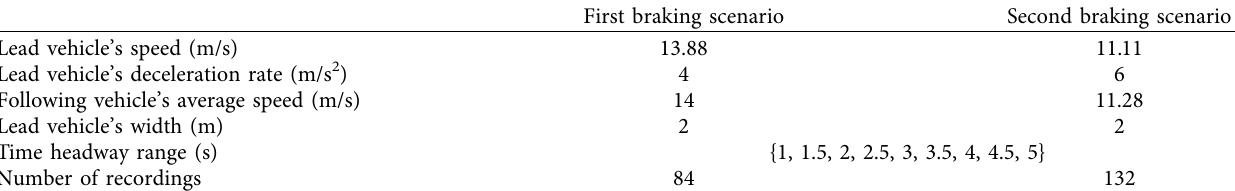
Table 2: The dataset for analysis.